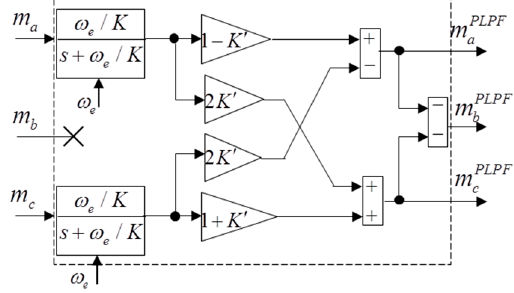
Figure 3. The extended PLPF to obtain filtered three-phase variables.